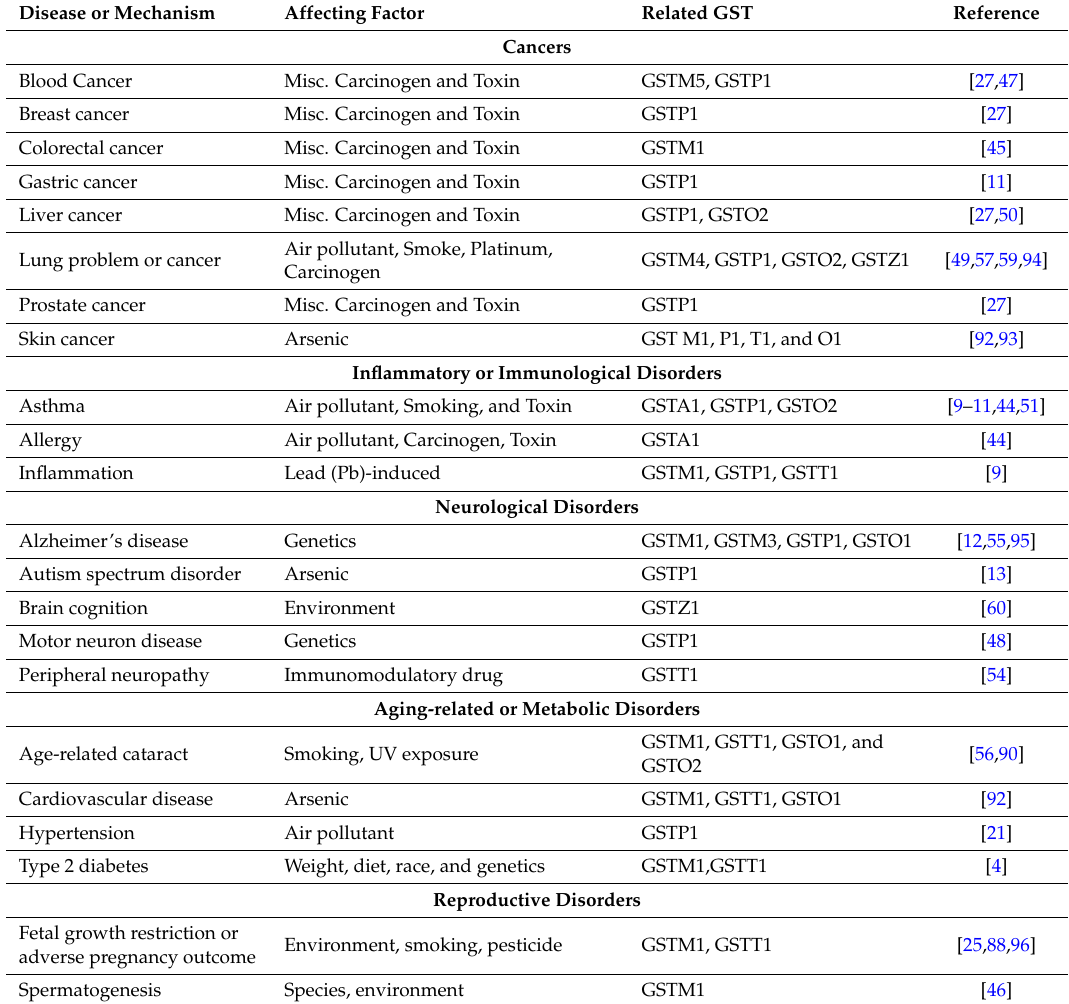
Table 6. Miscellaneous diseases or mechanisms related to GST